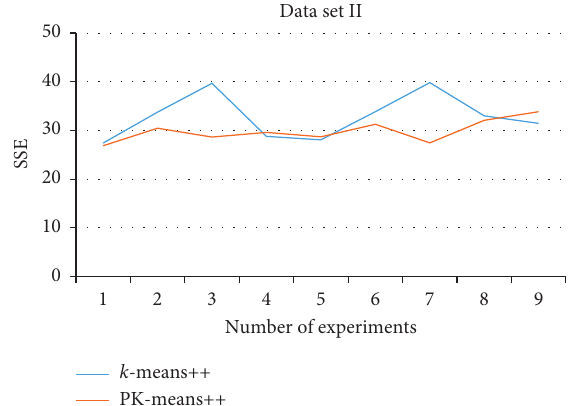
Figure 9: Comparison of the SSE on data set II.